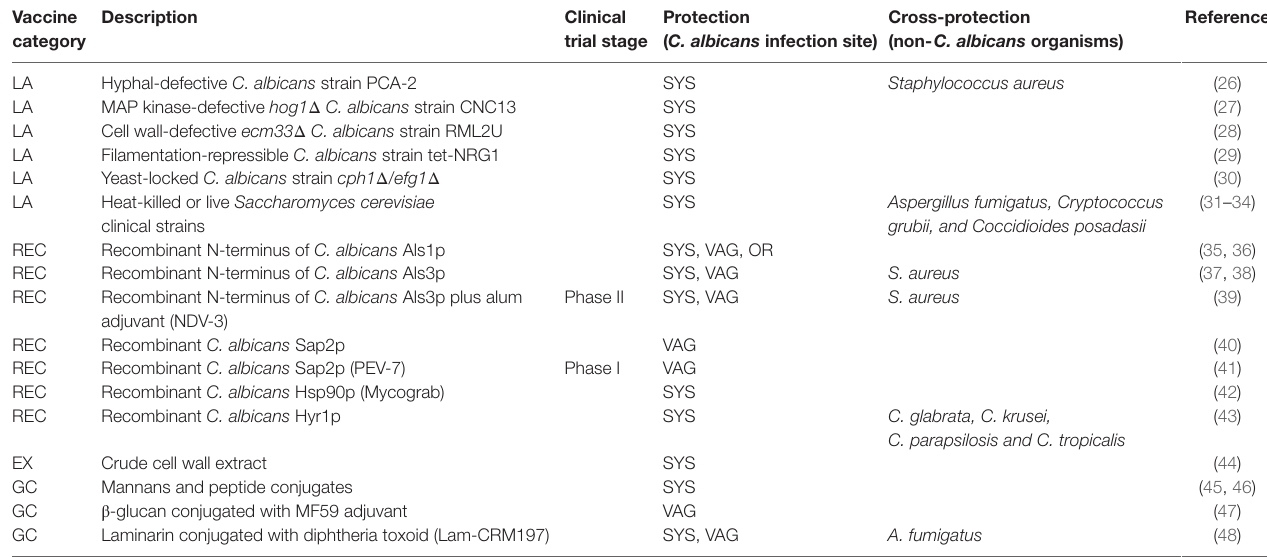
TAbLe 1 | Summary of past and current anti- Candida vaccine candidates. vaccine category